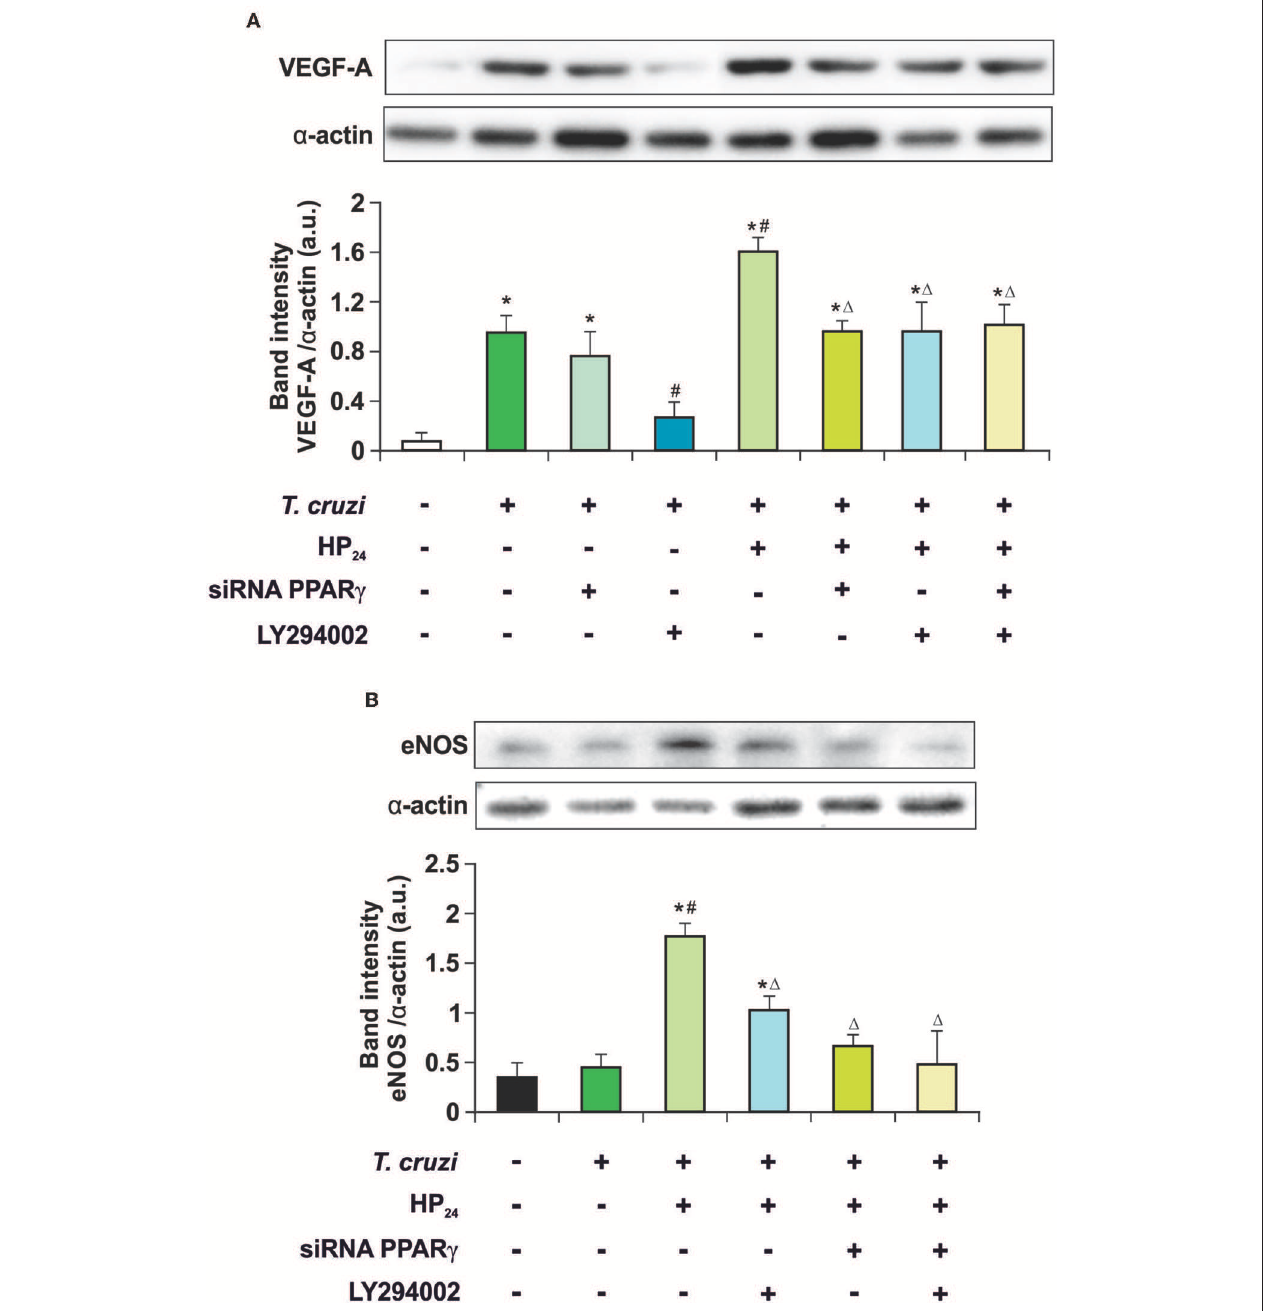
FIGURE 3 | HP 24 regulates eNOS and VEGF-A expression by PPAR γ and AKT signaling pathway. Peritoneal macrophages from T. cruzi -infected mice (9 dpi) were obtained. Cells were transfected with PPAR γ -siRNA during 72h. Transfected or non-transfected cells were treated with HP 24 (100 µ M) or HP 24 (100 µ M) plus LY294002 (30 µ M) for 48h. (A,B) Expression of eNOS and VEGF-A was determined by Western blot, and protein levels were normalized against α -actin. Results represent the mean ± SEM of three independent experiments (six mice/group). * P < 0.05 vs. uninfected cells, # P < 0.05 vs. T. cruzi -infected cells. 1 P < 0.05 vs. T. cruzi -infected HP 24 -treated